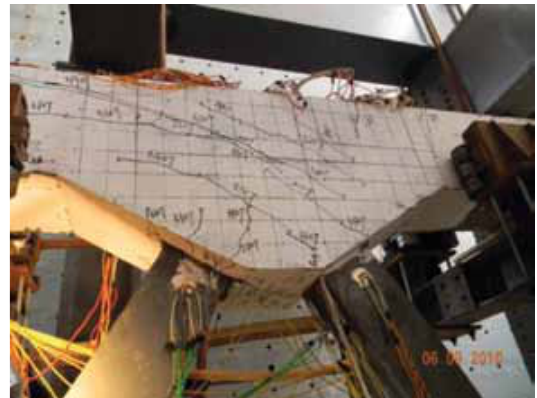
Fig. 6. Distribution of ZHJD-1 concrete cracks P = 3800 kN